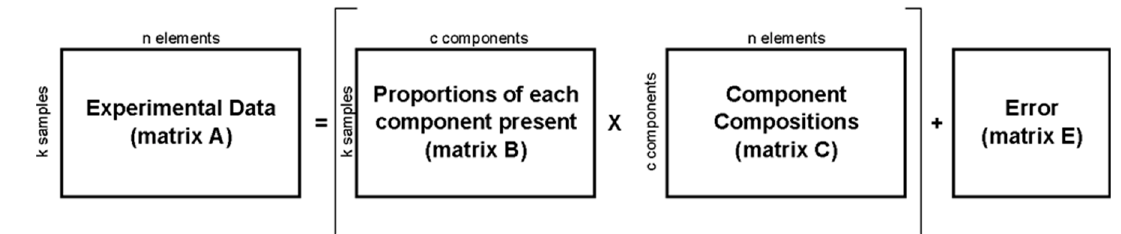
Figure 4. Representation of the Self Modelling Mixture Resolution (SMMR) algorithm.